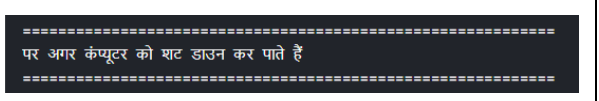
Fig 5.1 Output of Trigram model